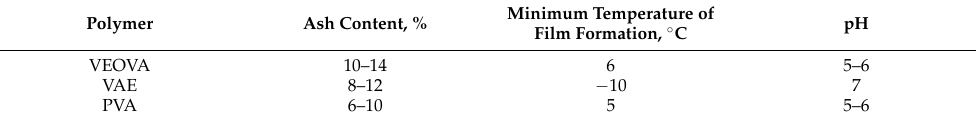
Figure 2. Device for determining the structural strength.